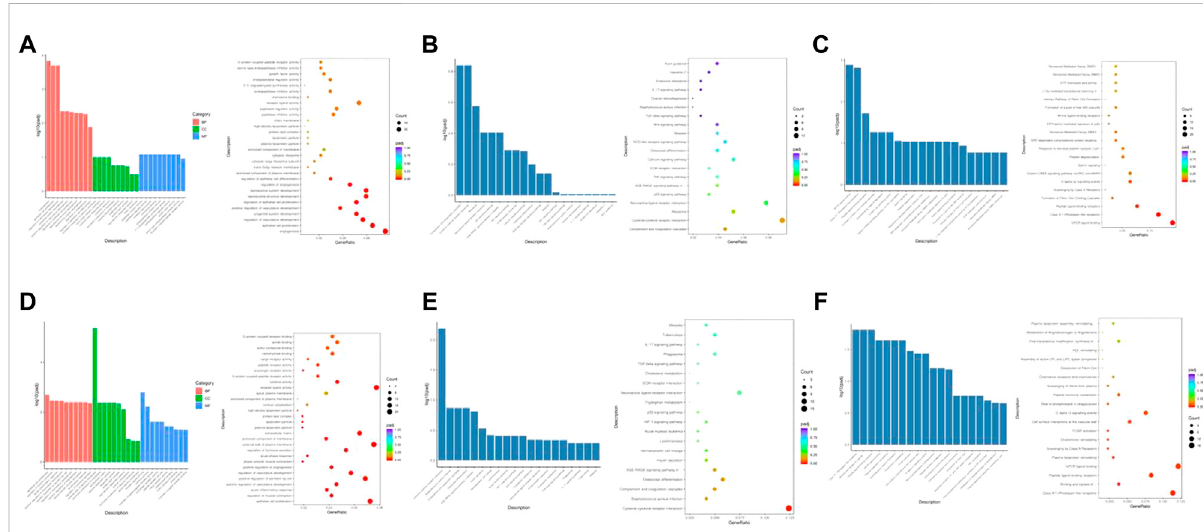
FIGURE 4 Enrichment analyses of differentially expressed genes at 3 months after radiation. (A) GO function enrichment analysis, (B) KEGG pathway analysis, and (C) Reactome enrichment analysis of differentially expressed mRNAs in the low-dose irradiation group after 3 months (D) GO function enrichmentanalysis, (E) KEGGpathwayanalysis,and (F) ReactomeenrichmentanalysisofdifferentiallyexpressedmRNAsinthehigh-doseirradiation group after 3 months.